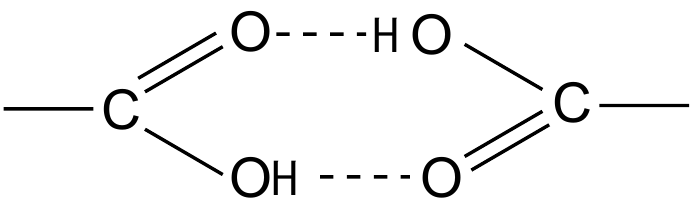
Figure 2. Intermolecular hydrogen bonds between the carboxyl groups in the DPAC monomer. The dimers of carboxyl groups are destroyed during the polymerization of DPAC in an alkaline medium. The COOH groups ( ν C= О = 1675 and 1224 cm − 1 ) are associated with the N–H groups ( ν N–H = 3175 cm − 1 ) of the main chain. The carboxyl groups along the entire polymer chain form intramolecular hydrogen bonds with the amine groups. The absorption band at 3264 cm − 1 characterizes the associated COOH—N–H carboxyl groups with the hydrogen bond. In the structure of the polymer synthesized in an acidic medium (5 M H 2 SO 4 ), the association of carboxyl and amine groups is